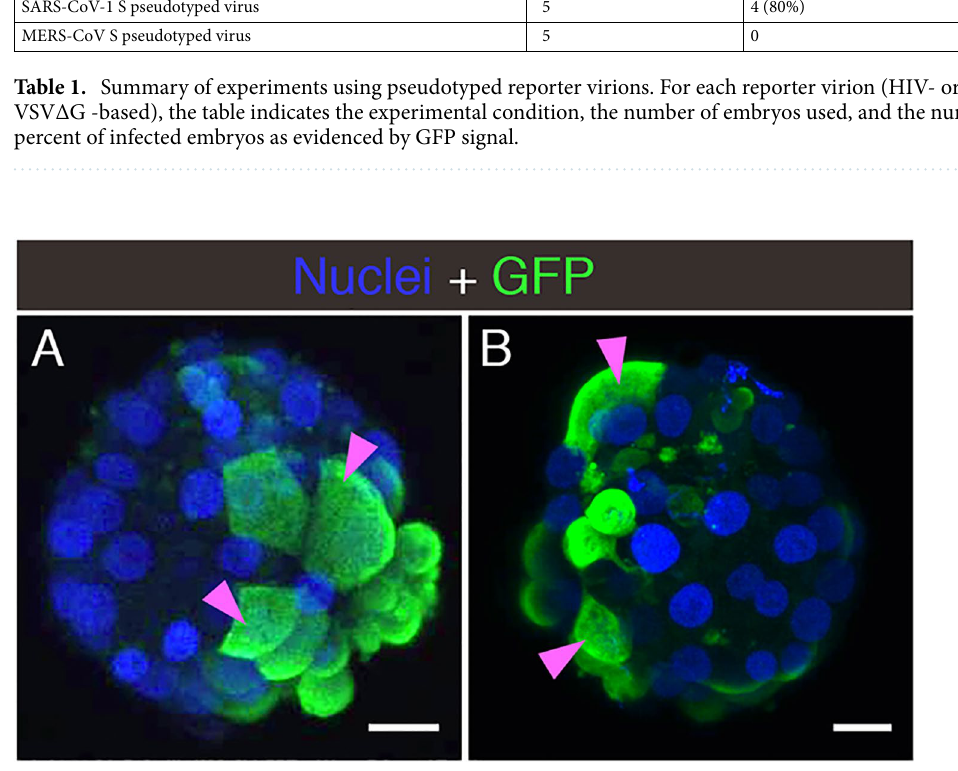
Figure 3. Embryo Infection by Reporter Virions Pseudotyped with the S protein of SARS-CoV-2. Sample confocal MIP images of embryos infected with ( A ) HIV- based or ( B ) VSV∆G -based reporter virions pseudotyped with the S protein from SARS-CoV-2. Pink arrowheads point to cells displaying robust signal. Scale bars represent 20 µm. Representative images from independent biological replicates (n = 15 embryos with HIV- based virion, n = 7 embryos with VSV∆G -based